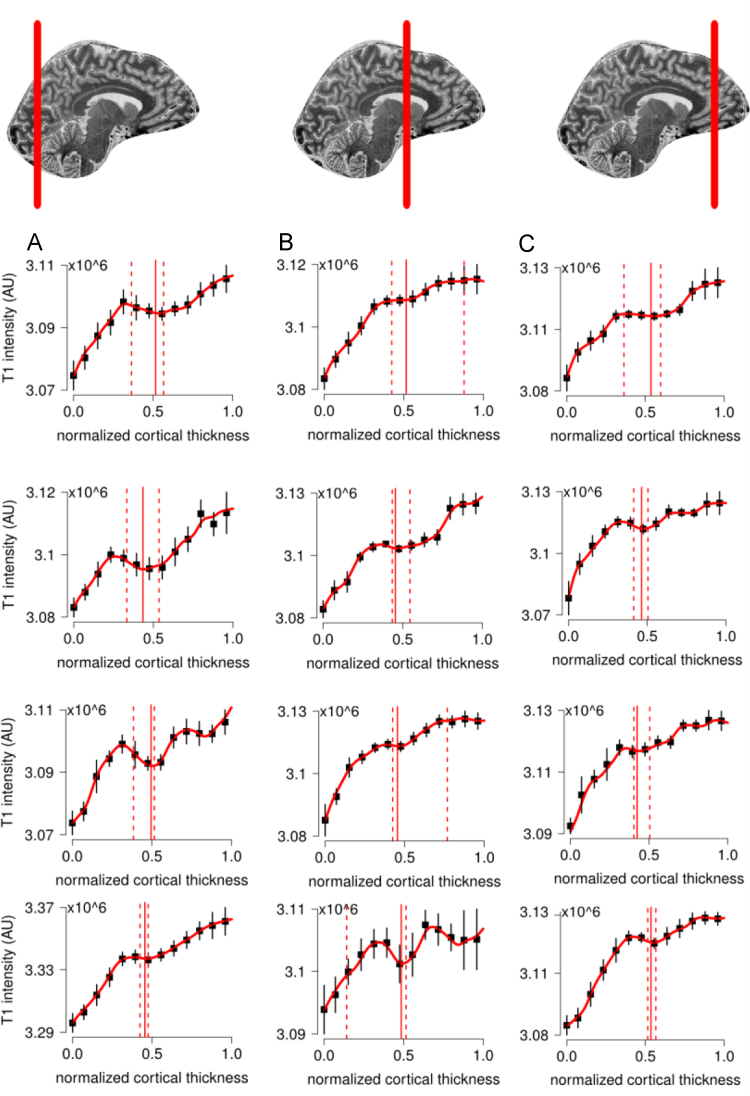
For the complete description see the caption of Fig. 5.